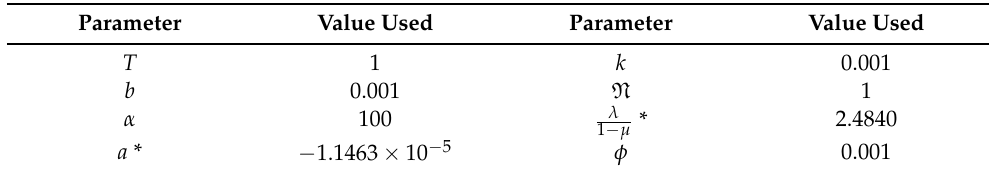
Table 2. Liquidation parameters for Apple stock.